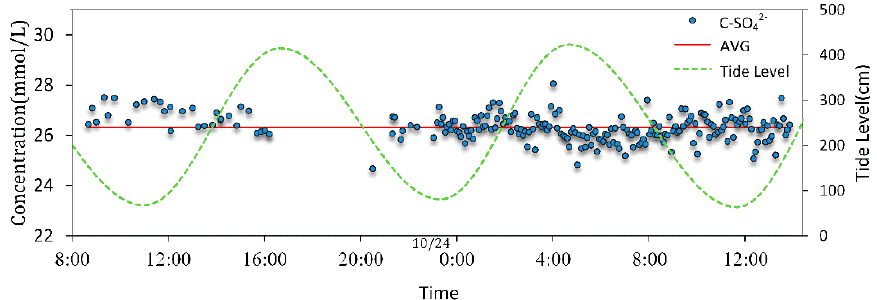
Figure 7. The temporal change of retrieved SO 42 − concentrations detected by a Raman spectral system. (C-SO 42 − , retrieved SO 42 − concentration; AVG, the average of SO 42 − during the day). The data between 16:12–20:30 were missing due to power off.